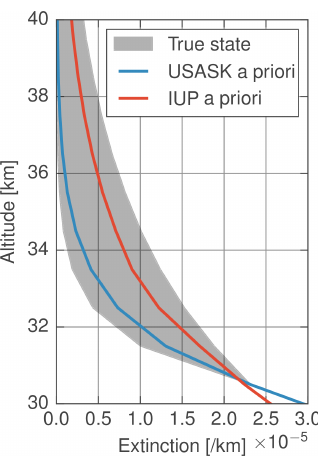
Figure 3. The range of the true state aerosol profiles is shown as the shaded region. The USask a priori is shown in blue and the IUP in red.